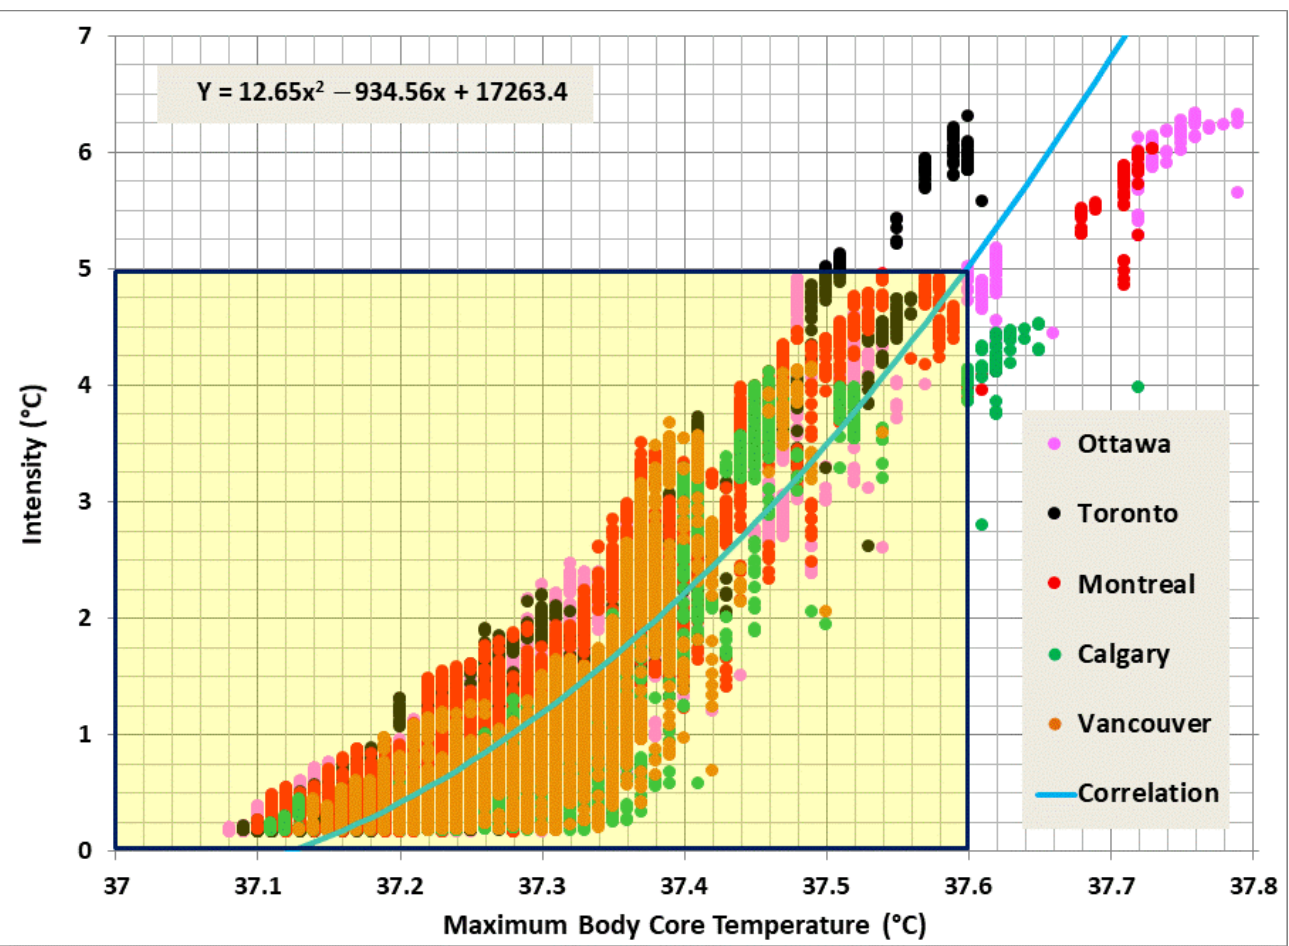
Figure 9 . Severity of overheating events versus body water loss in LTCHs.